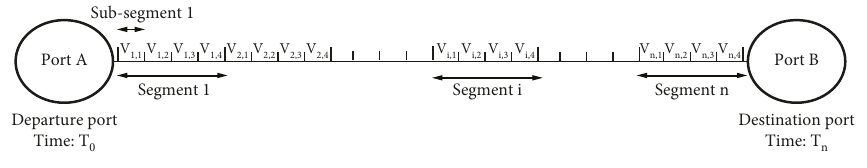
Figure 7: Speed optimisation problem.